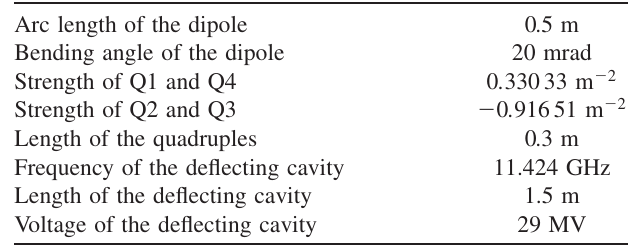
TABLE I. Main parameters used for the simulations. Arc length of the dipole